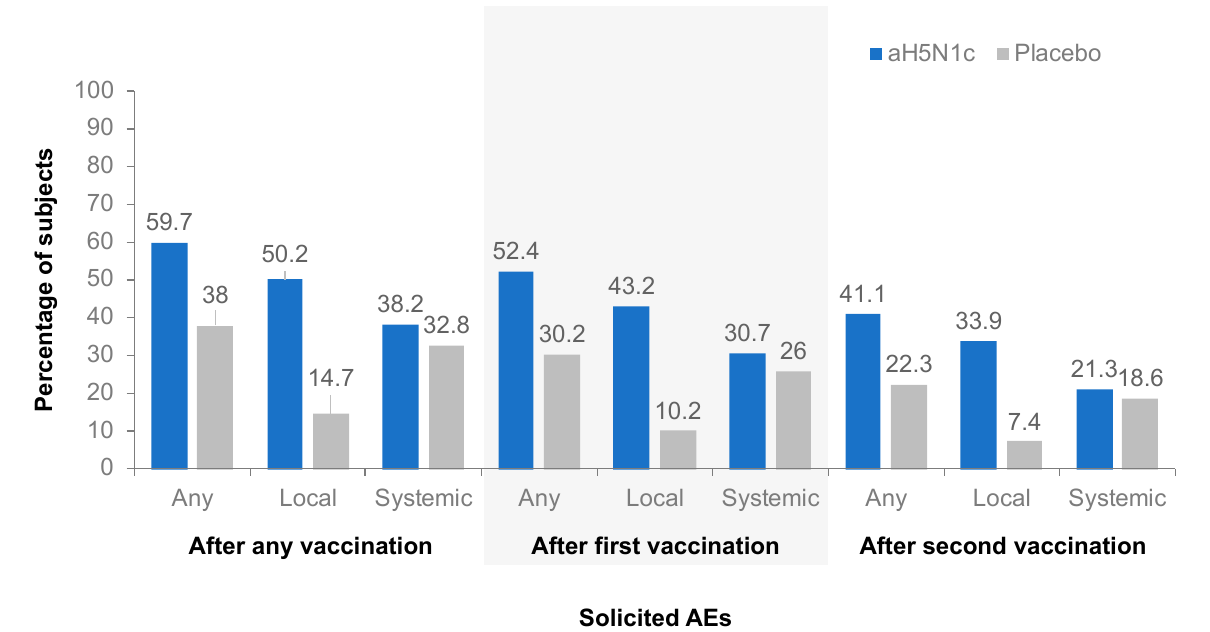
Figure 3. Percentages of subjects with at least one solicited adverse event (AE) within 7 days after the first, second, or any vaccination.